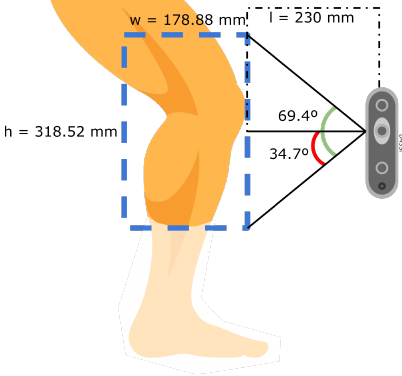
Figure 3. A vision area of 318.52 × 178.88 px at 230 mm from the target using the D435i stereo camera. This results in a resolution of 0.24 mm px